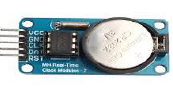
Fig.8. Authentication of an owner and access of an